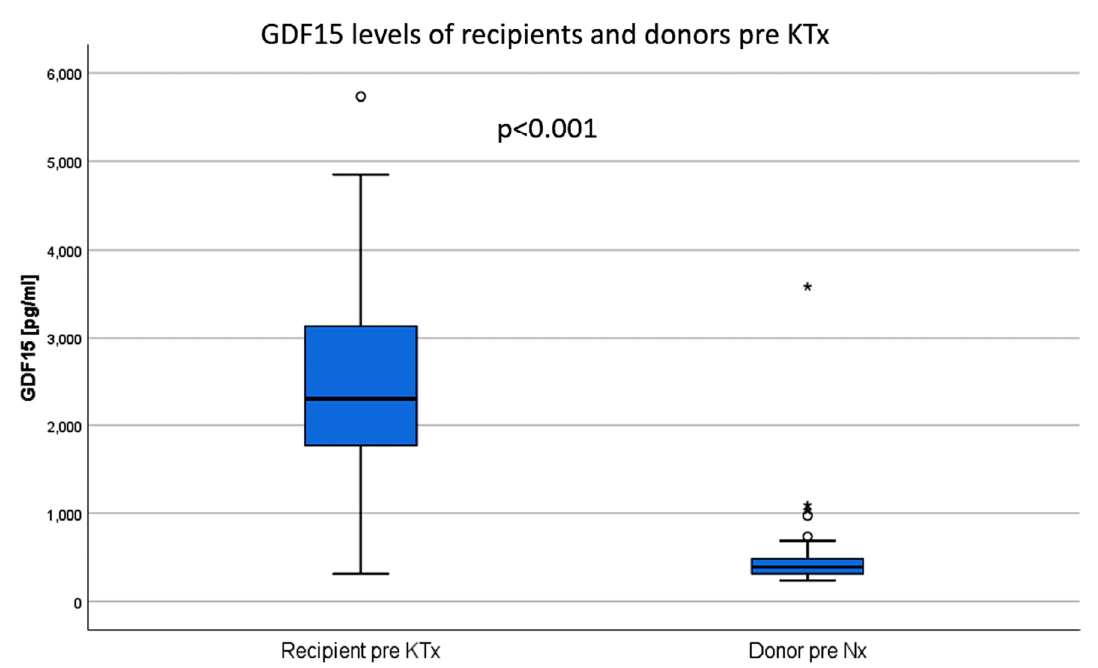
Figure 1. The mean GDF15 values of patients with end-stage renal disease are significantly higher than in healthy controls (living donors before donation). KTx: kidney transplantation, Nx: